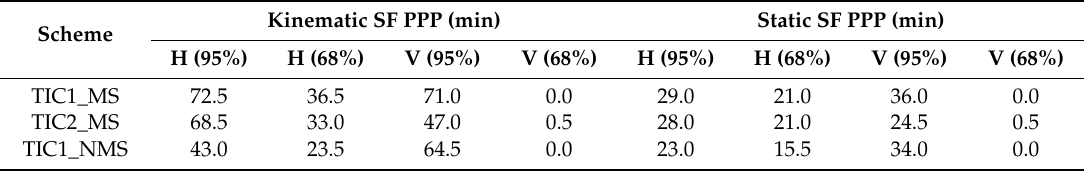
Table 6. The convergence times of GPS static and kinematic SF PPP in MS and NMS of TIC1 or TIC2.